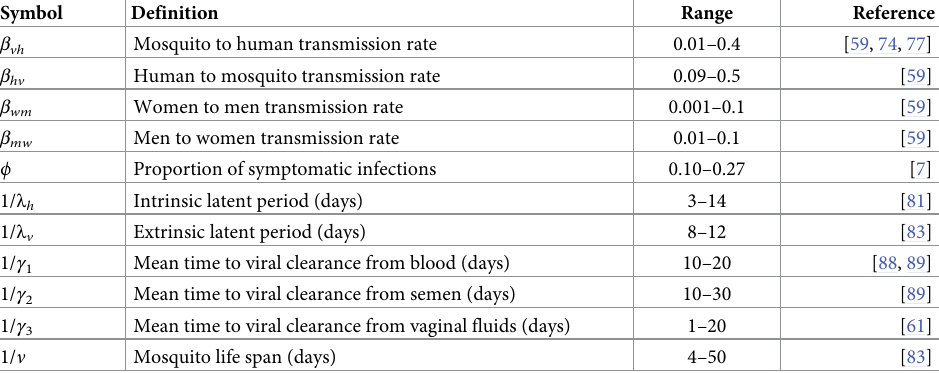
Table 1. Model parameters and their estimated realistic